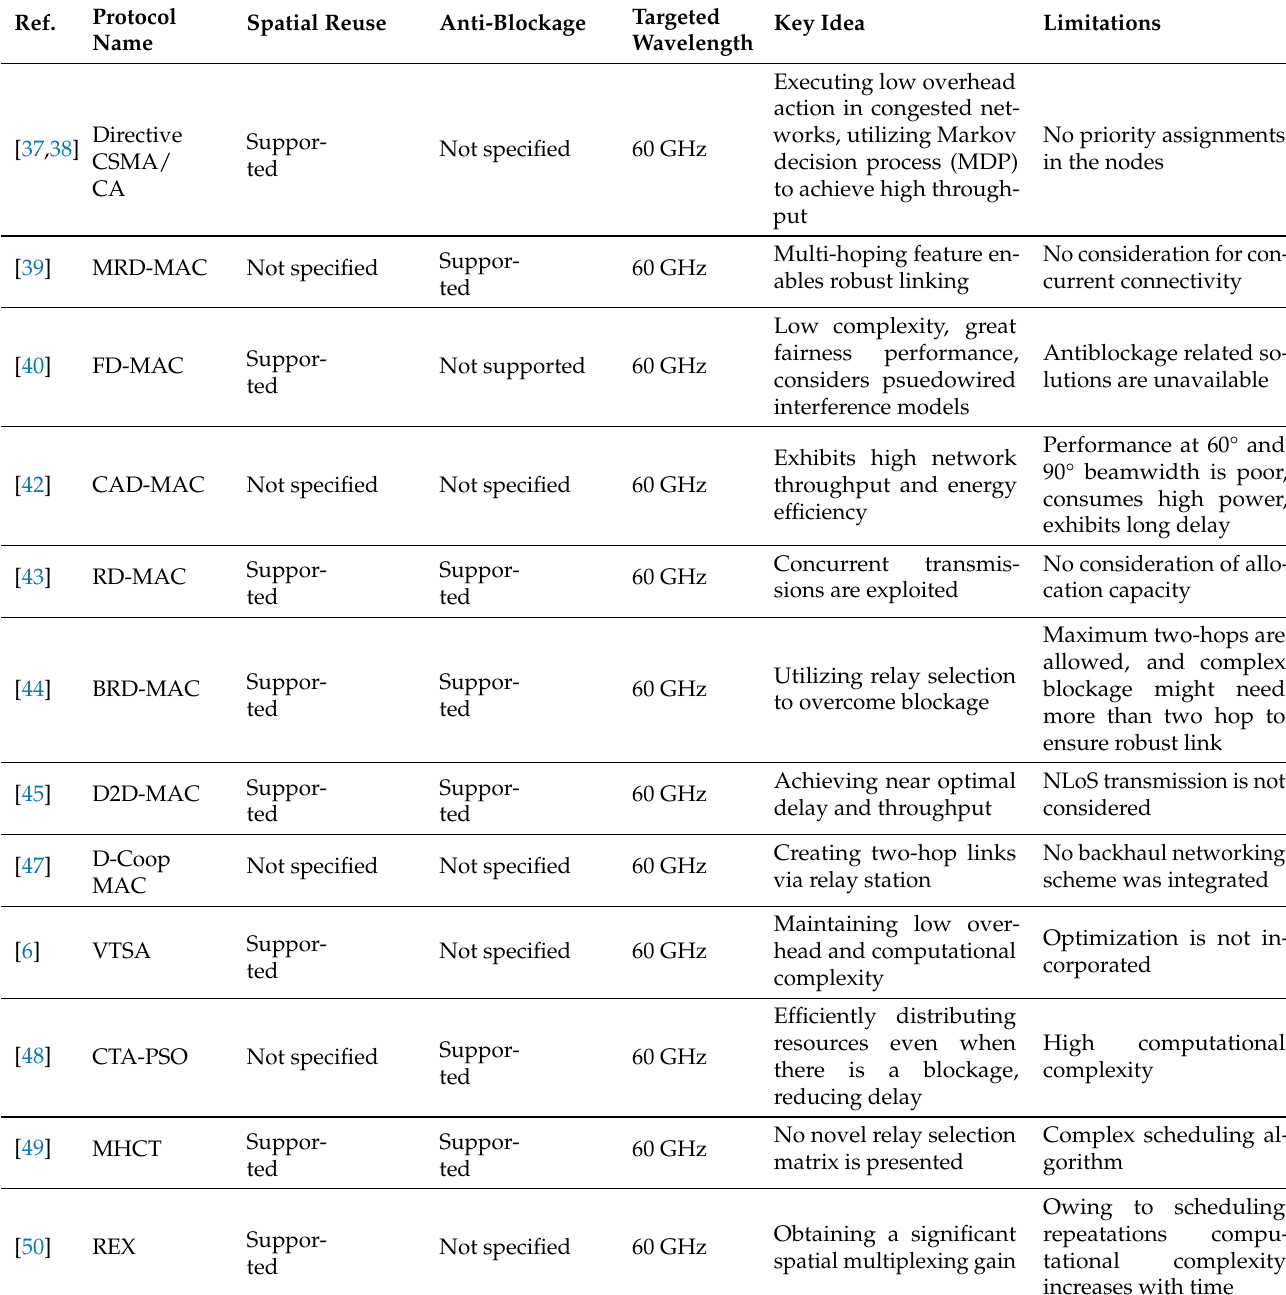
Table 3. Comparative analysis of centralized MAC